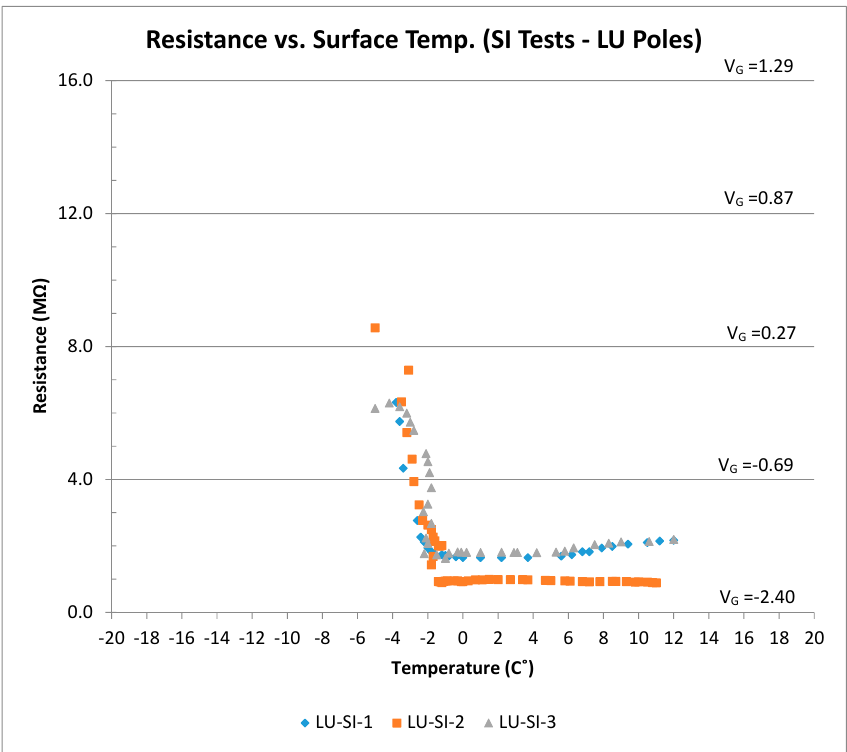
Figure 13. Resistance (and voltage) versus surface temperature for all SI tests (LU Poles). Sensors 2017 , 17 , 2912